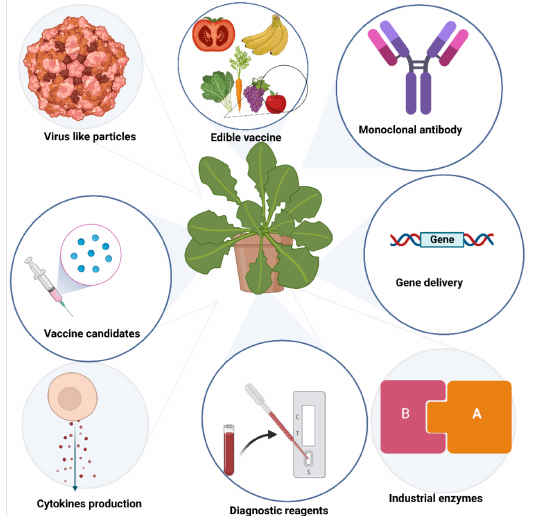
Figure 1. Biologics produced in